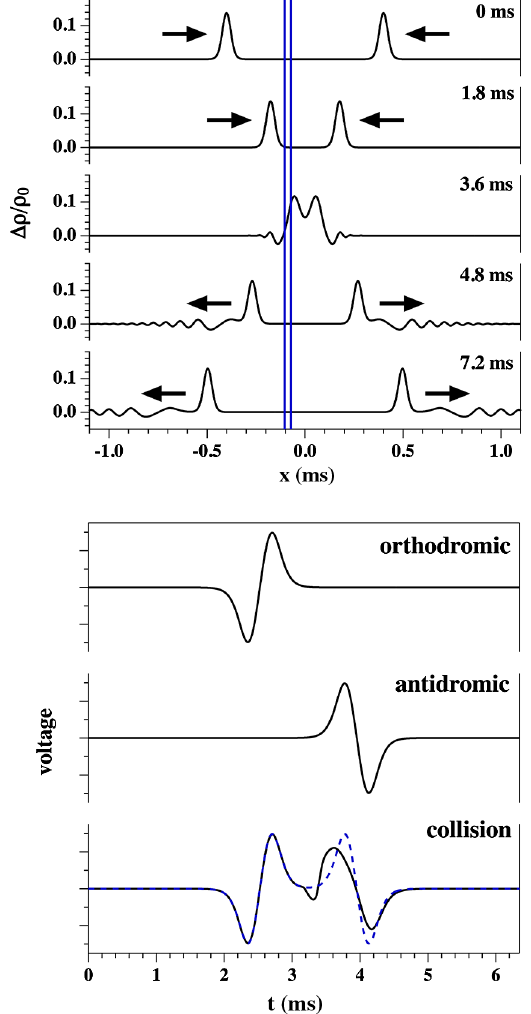
FIG. 5. Top panel: The collision of two pulses in the soliton theory of nerves for v ¼ 0 . 7 c 0 . Parameters are given in the text. After collision, the shape of the solitary pulses is virtually unchanged. The two blue lines indicate the positions of two hypothetical recording electrodes with a distance of 16 mm. Bottom panel: The calculated voltage difference between the two electrodes shown in the top panel. The top trace shows the single orthodromic AP, the center trace shows the antidromic AP, and the bottom trace (solid) shows the recording of the two colliding pulses. The dashed blue line is the sum of the orthodromic and antidromic without a collision. It is added as a guide to the